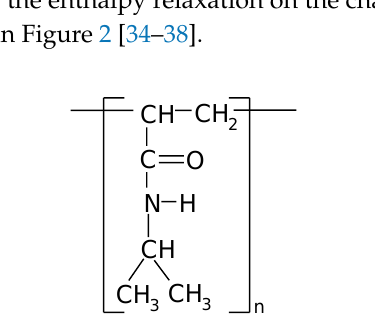
Molecules 2020 , 25 , x FOR PEER REVIEW